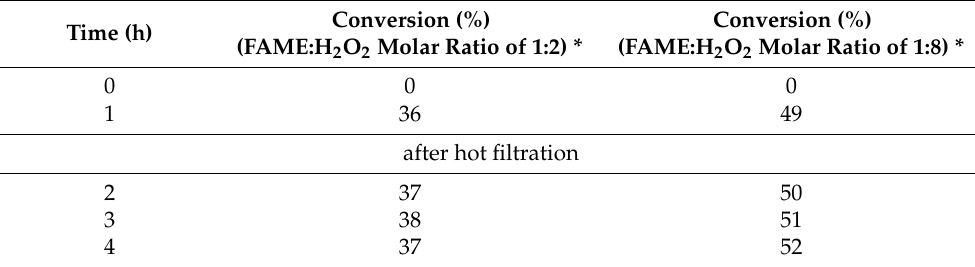
The results of the PW4@MIL-100(Cr) catalyst recycling test are shown in Figure 8. The epoxidation reaction was carried out at 40 ◦ C with a molar ratio of * Reaction conditions: FAME content of 1 wt%, temperature of 40 °C and catalyst content of 15 g·L − 1 . Figure 6. The catalyst loading influence on the unsaturated FAME conversion ( a ) and epoxides se- lectivity ( b ). Reaction conditions: FAME content of 1 wt%; unsaturated FAME:H 2 O 2 molar ratio of 1:8; temperature of 60 °C; and catalyst loading of 30 g·L − 1 ( ), 15 g·L − 1 ( ), 7.5 g·L − 1 ( ) and 3.75 g·L − 1 ( ). The highest epoxide yield (70%) at 60 °C and a molar ratio of unsaturated FAMEs:H 2 O 2 of 1:8 was achieved after 45 min when the PW4@MIL-100(Cr) catalyst loading was 15 g·L − 1 .